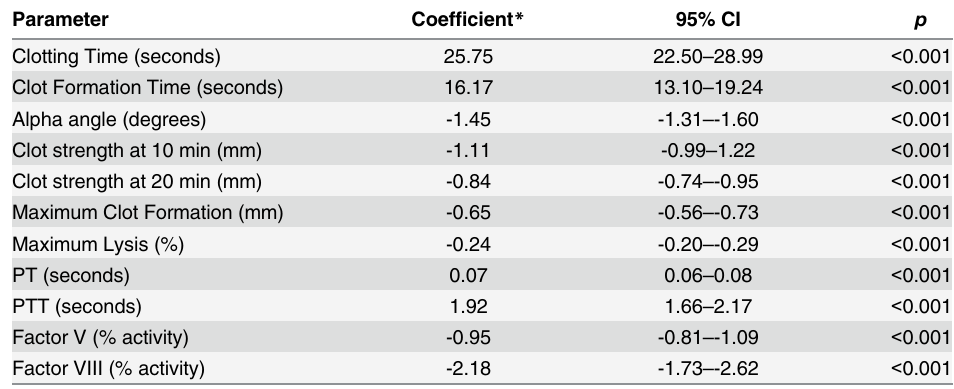
Table 1. Mixed-effects regression modeling, change in coagulation parameters per 100ng/mL